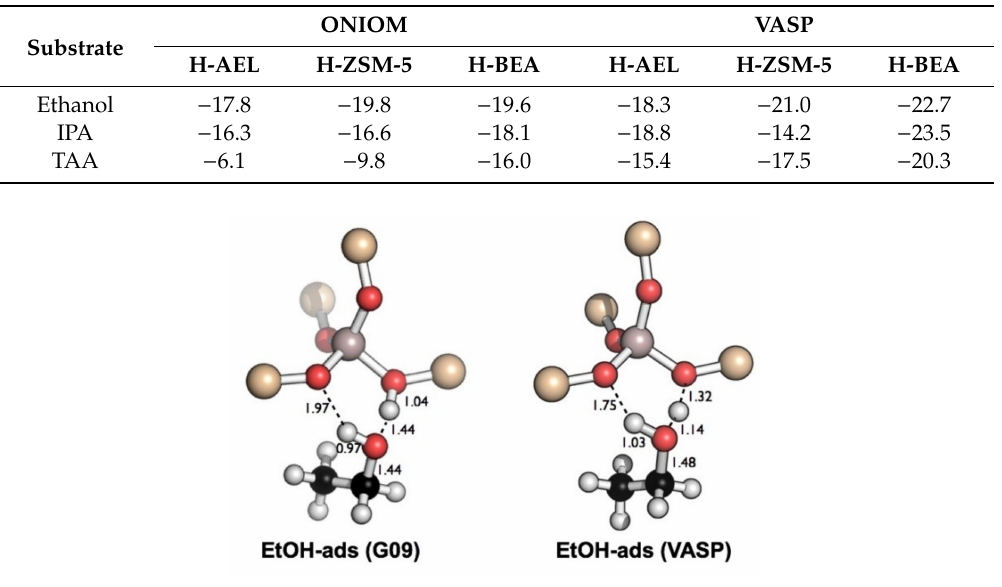
Figure 5. Optimized geometries (distances in Å) of adsorbed ethanol in H-BEA using ONIOM (M06-2X / 6-311G(d,p):PM6) in Gaussian 09 (G09) and periodic boundary conditions in VASP. (black: C atom; white: H atom; red: O atom; brown: Si atom; gray: Al